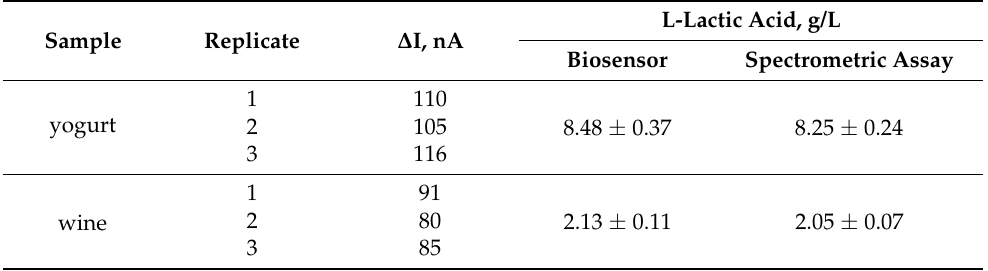
Table 3. L-lactic acid determination in yogurt and red wine